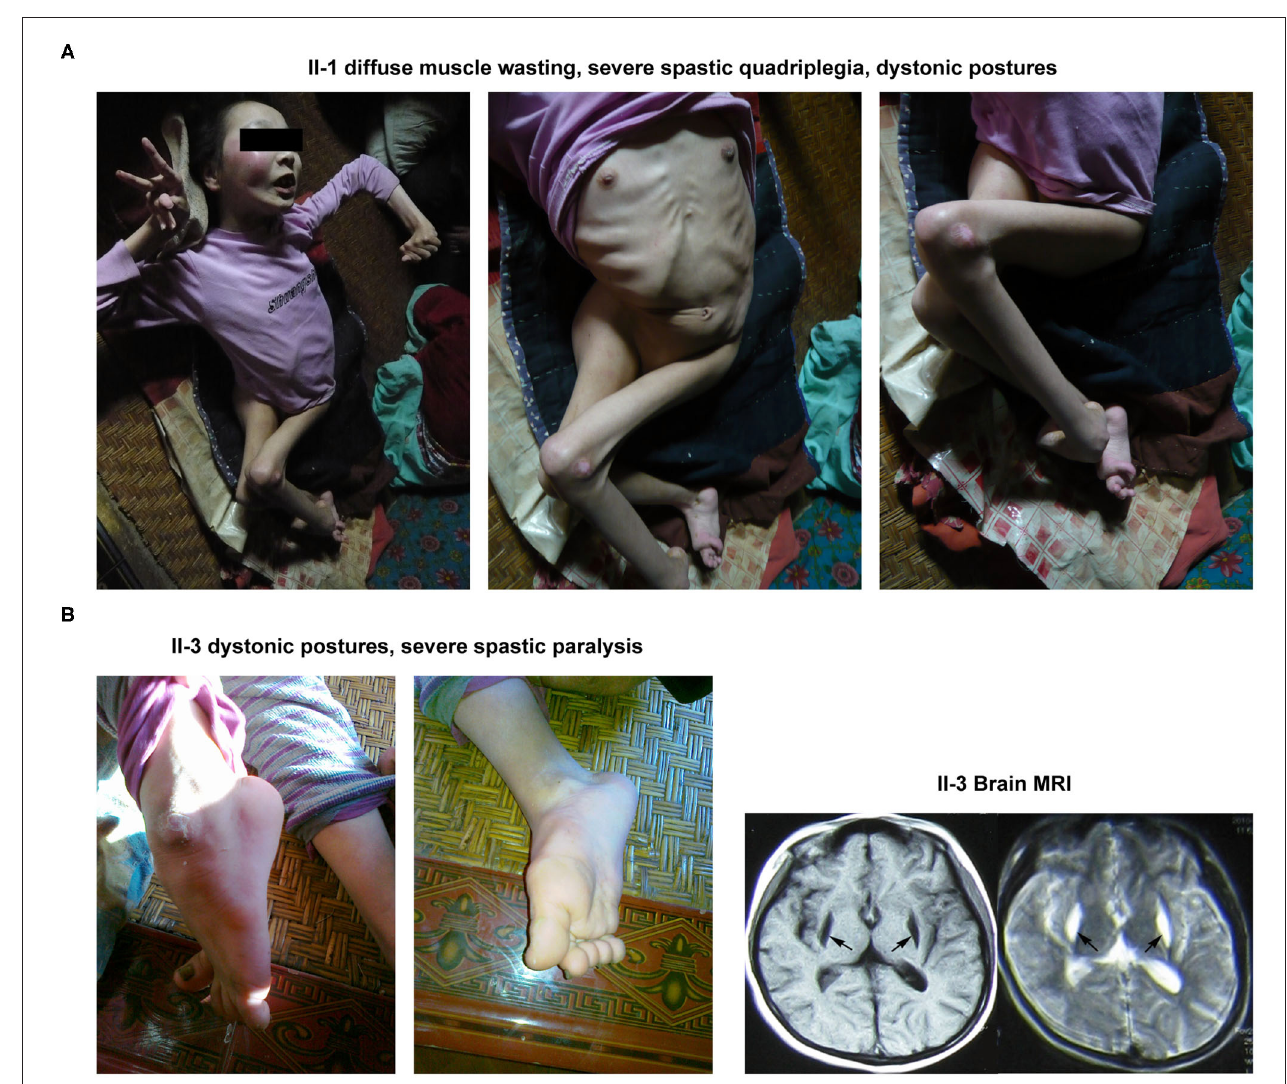
FIGURE 2 | Clinical manifestations of the other 2 patients (II-1 and II-3) in this family. (A) The abnormal appearance of II-1. (B) The dystonic posture in lower limbs and brain MRI result of